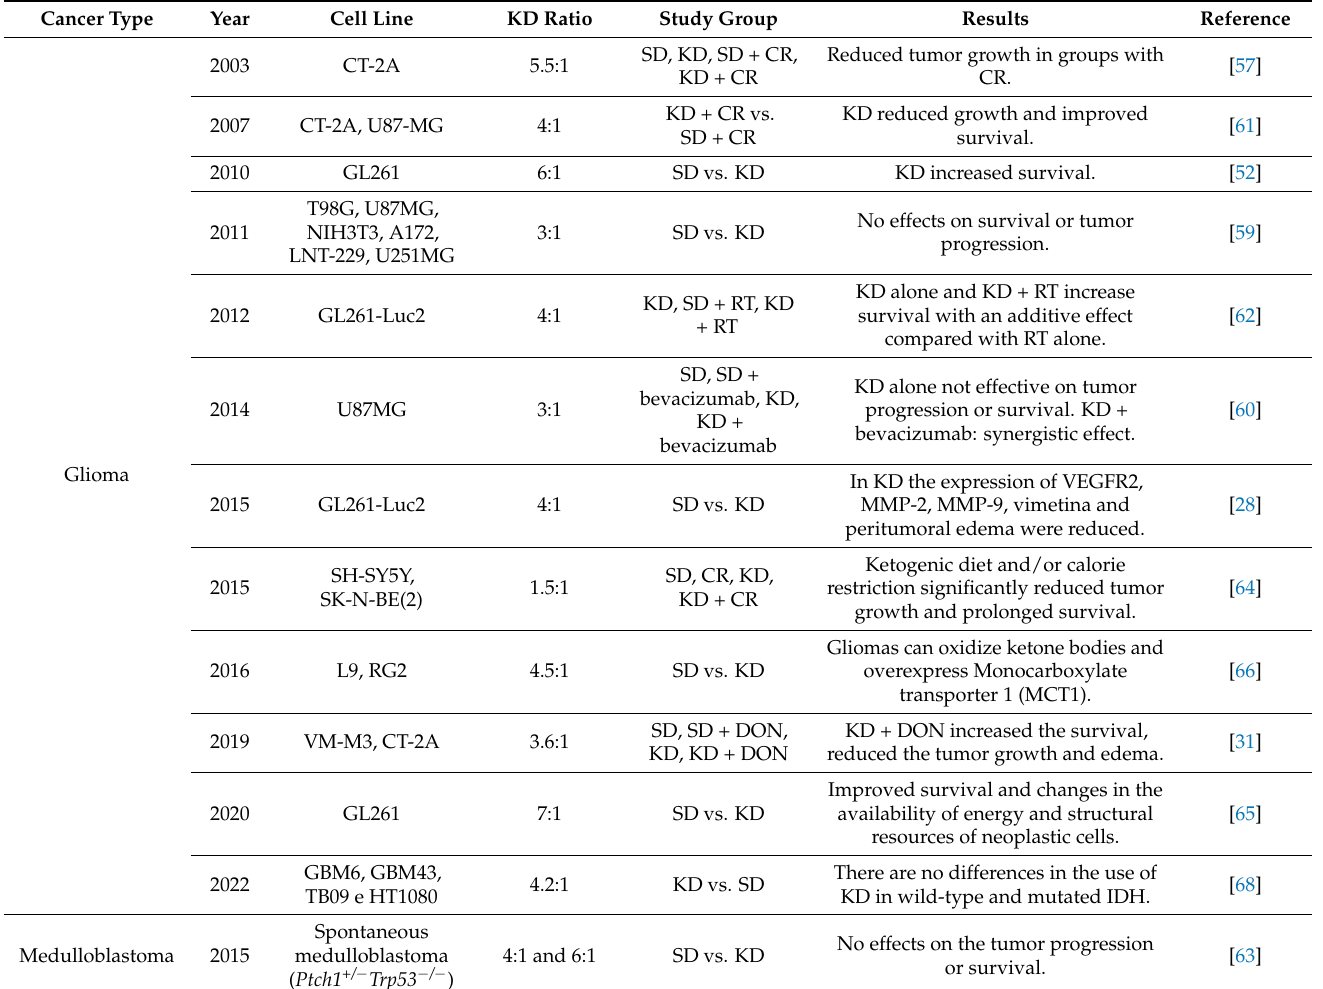
Table 1. The main pre-clinical studies in mouse